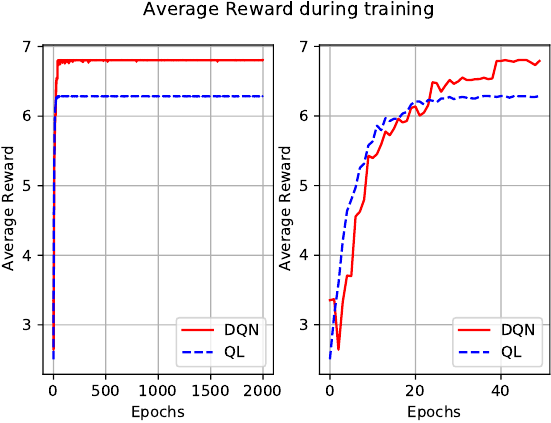
Figure 5. The average reward during the learning episodes.